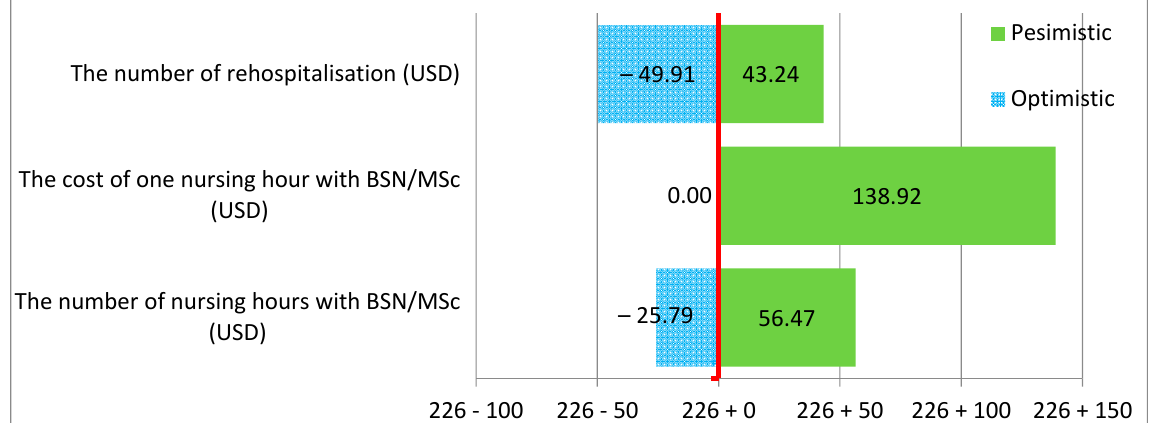
Figure 2. Increasing the percentage of care provided by nurses with BSN/MSc degrees by 10% in non-surgical wards.